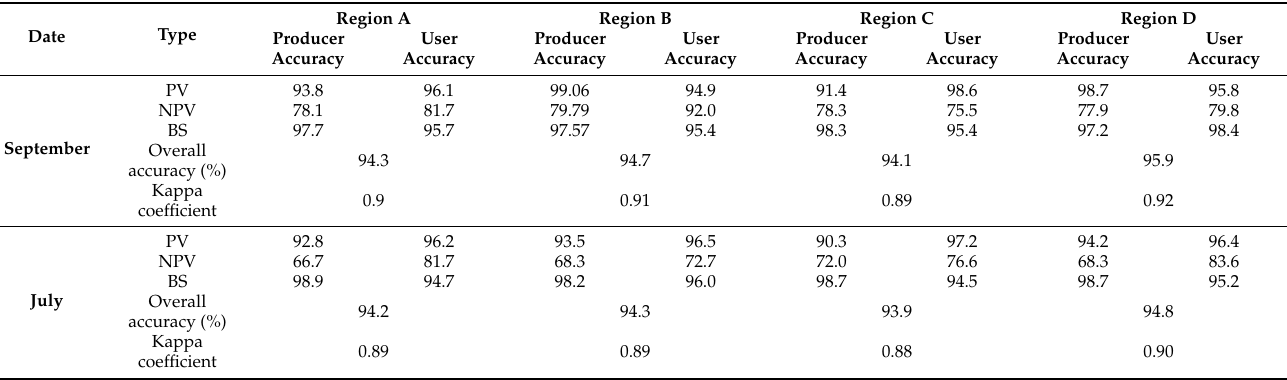
Figure 9. Comparison of PV – NPV estimation results by region for July and September, indicating model migration capability(The data from September Region A were selected to train the model, September Regions B, C, and D, and July Regions A, B, C, and D were used to verify the migration capabilities of the model). Table 5. PV/NPV estimation accuracy of the DeepLabV3+ model migrated to September and July for each